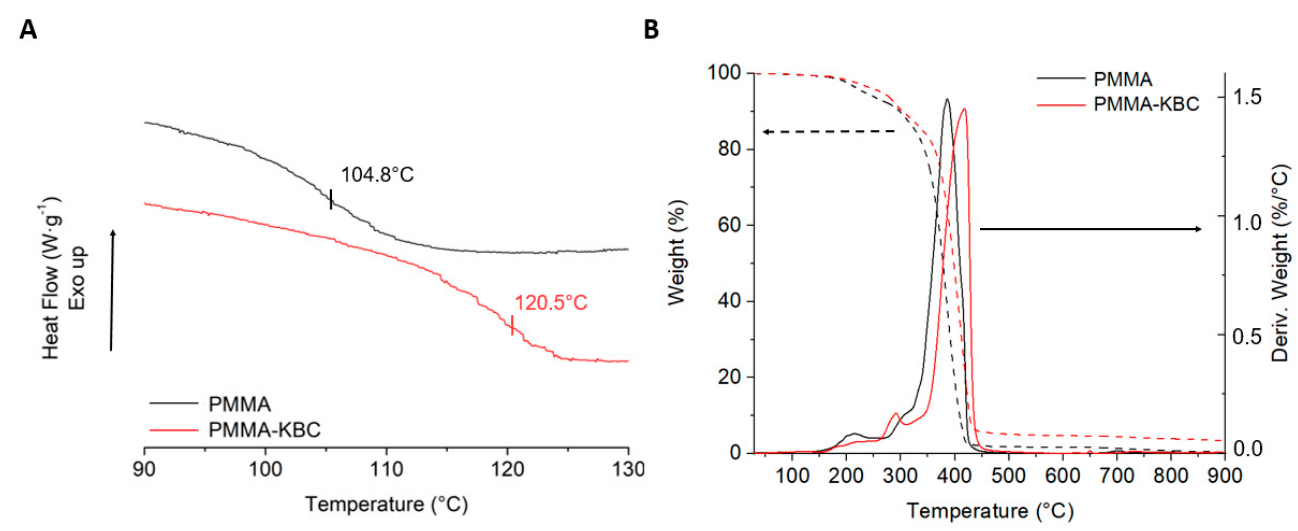
Figure 10. Thermal properties of PMMA and PMMA-KBC nanocomposites. ( A ) DSC thermograph magnification of the T g of neat PMMA and PMMA-KBC nanocomposite; ( B ) TGA weight loss (dash line) and weight loss rate (continuous) curves of the samples.